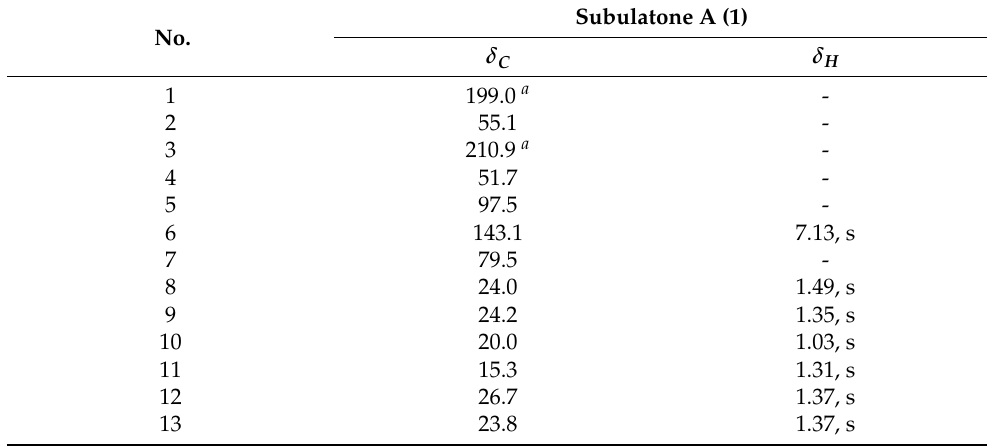
Table 1. 1 H and 13 C NMR spectroscopic data for subulatone A ( 1 ) in CDCl 3 ( δ in ppm, J in Hz). No.